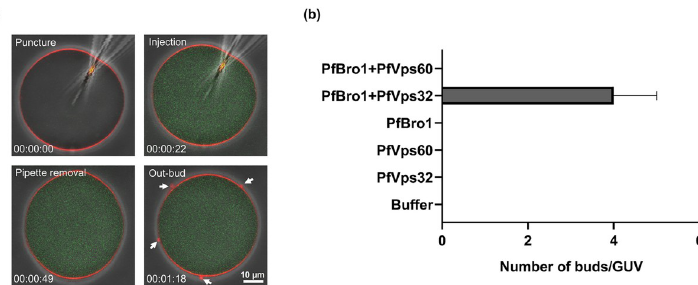
Fig 5. Injection of ESCRT-III Plasmodium proteins in GUVs and outward budding. (a) Panels show injection of a mixture of PfBro1 and PfVps32 (1:2) together with PEG-FITC in GUVs composed by POPC:POPS:DSPE-biotin (79:20:1) and labeled with DiI C18 (0.1 mol%). Four main events are presented: puncture, injection, pipette removal and generation of outward buds (arrows). (b) Graphical representation of bud number per GUV in the tested conditions for the injection approach. Bars represent the mean and standard error of the number of out-buds in four independent injected GUVs.